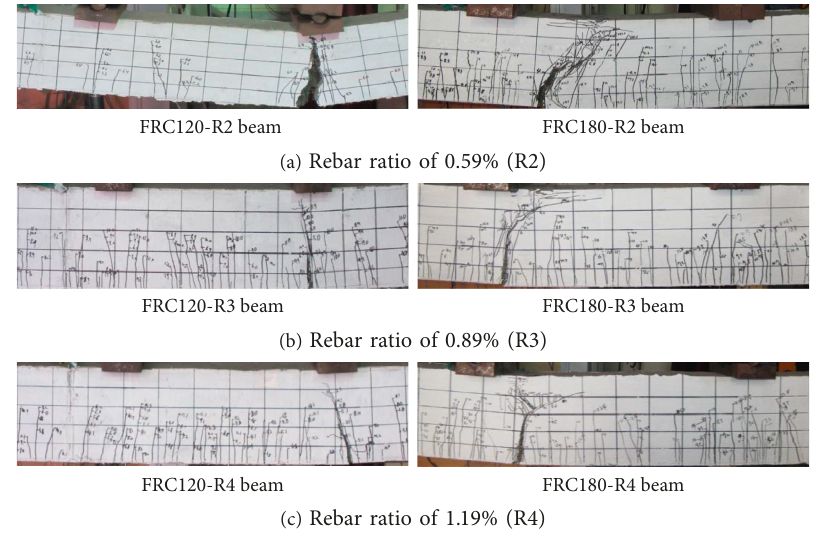
Figure 8: Cracking and failure of the UHPFRC beams.